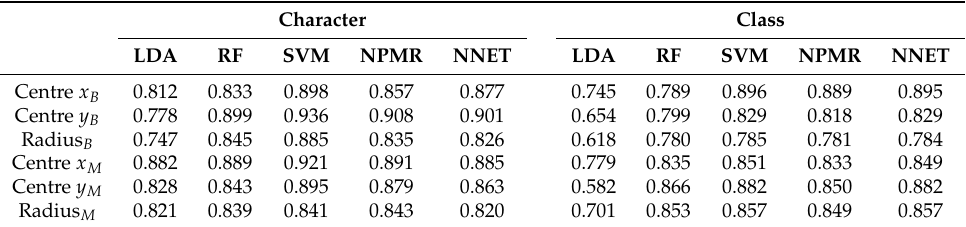
Table 2. Accuracy